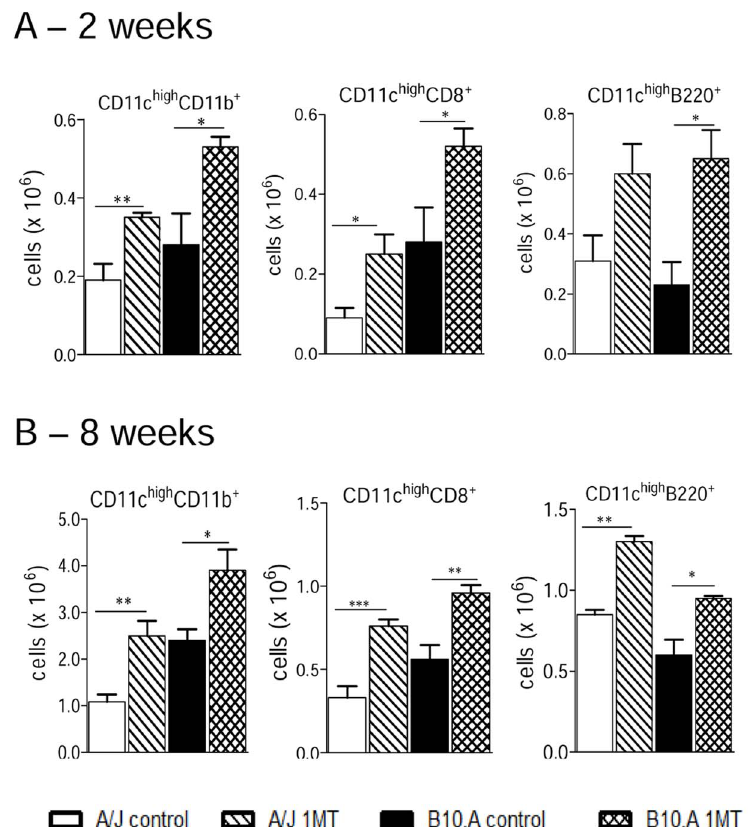
Figure 5. IDO inhibition increases the influx of myeloid (CD11c high CD11b + ), lymphoid (CD11c high CD8 + ) and plasmacytoid (CD11c high B220 + ) dendritic cells to the lungs of A/J and B10.A mice. 1MT treated or untreated B10.A and A/J mice were infected i.t. with 1 6 10 6 yeast cells of P. brasiliensis , and at 2 ( A ) and 8 ( B ) weeks after infection, lung inflammatory cells were obtained and lung DC subsets characterized using specific antibodies. Cell phenotypes were analyzed by flow cytometry as described in Materials and Methods. The data represent means 6 SEM of 5–7 mice per group and are representative of three independent experiments (* p , 0.05; ** p , 0.01; *** p , 0.001).